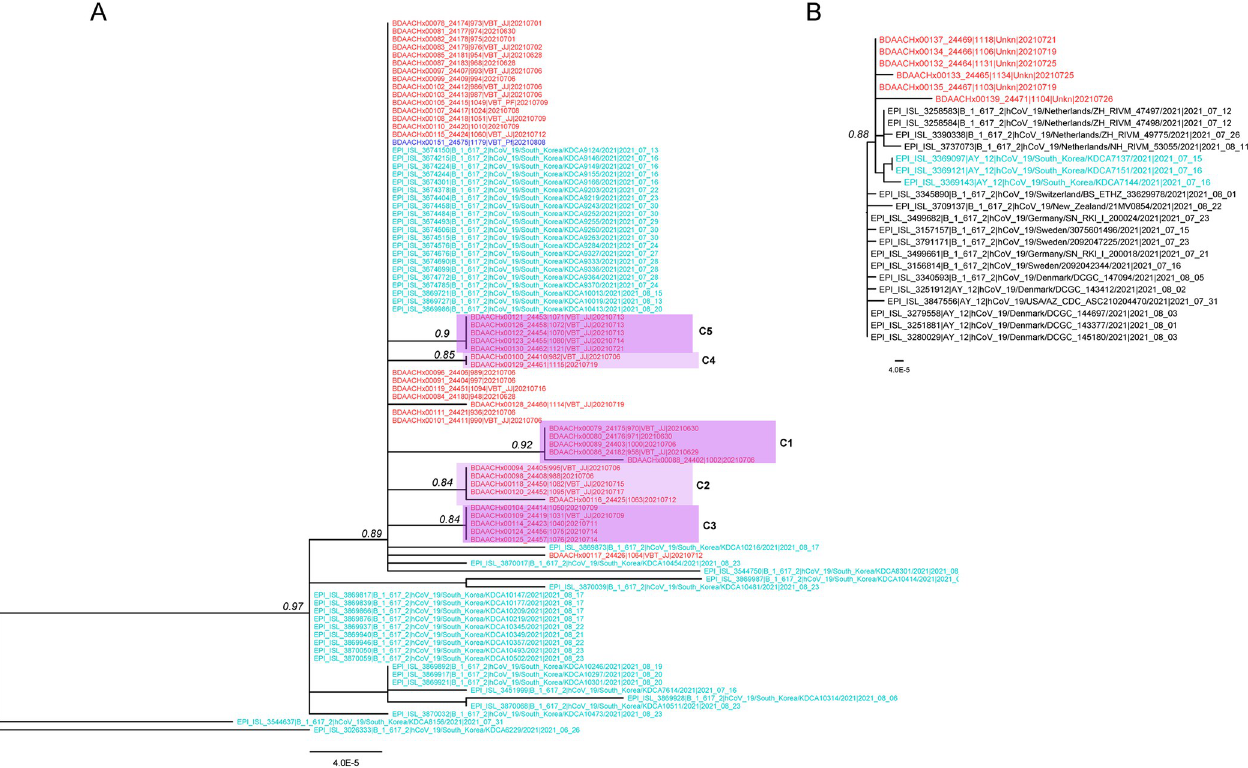
Fig 2. SARS-CoV-2 Delta sub-trees of the two USFK outbreaks. A) Sustained spread involving 86% of the genomes B) Sustained spread involving 9% of the genomes. USFK genomes collected June 27 to July 27 are colored red, those collected July 29 to August 10 are marked in dark blue. Local Korean population genomes are colored teal. Relevant node confidence values are displayed in